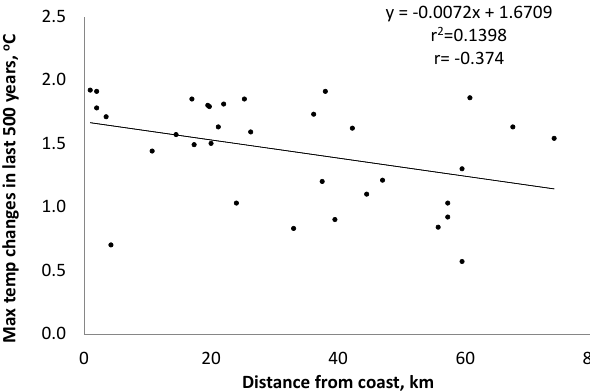
Figure 10. Correlation between the GTC and the distance of the borehole location from the